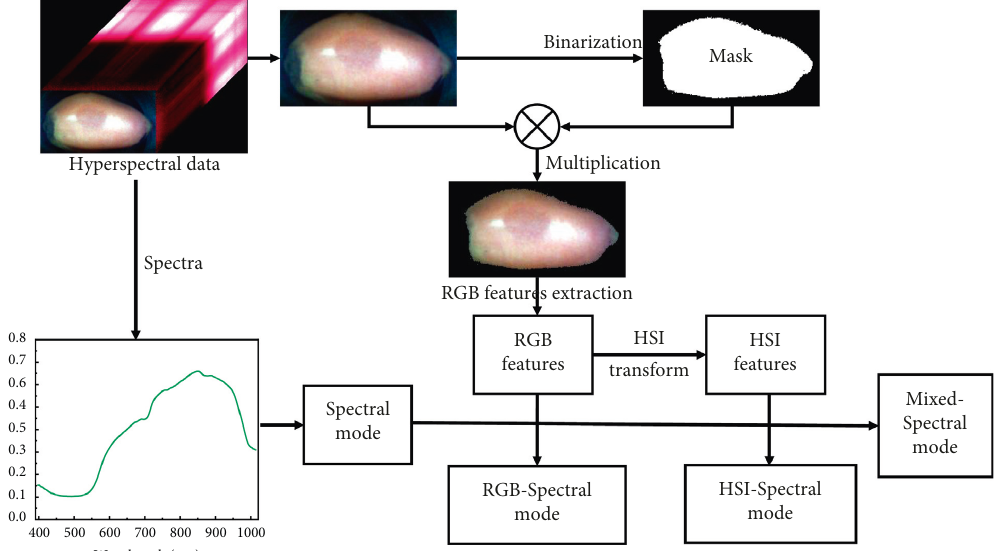
Figure 5: Flowchart of loquat image information